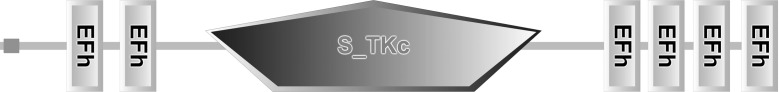
Genetically mobile domain and conservative structure analysis of the EtCDPK4.S_TKc, Serine/Threonine protein kinases, catalytic domain; EFh, calcium binding motif.